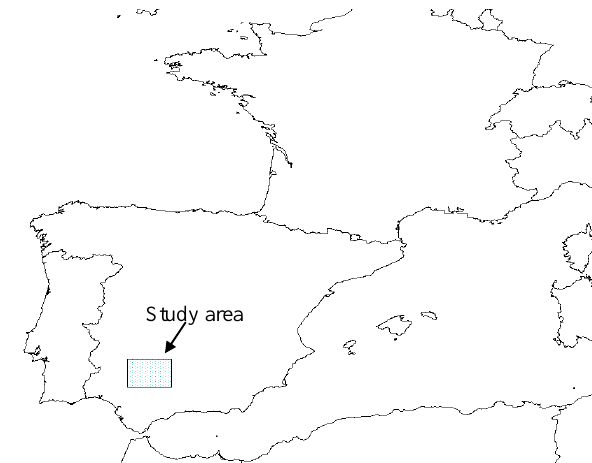
Figure 1. Study area. 3 Fig. 1. Study